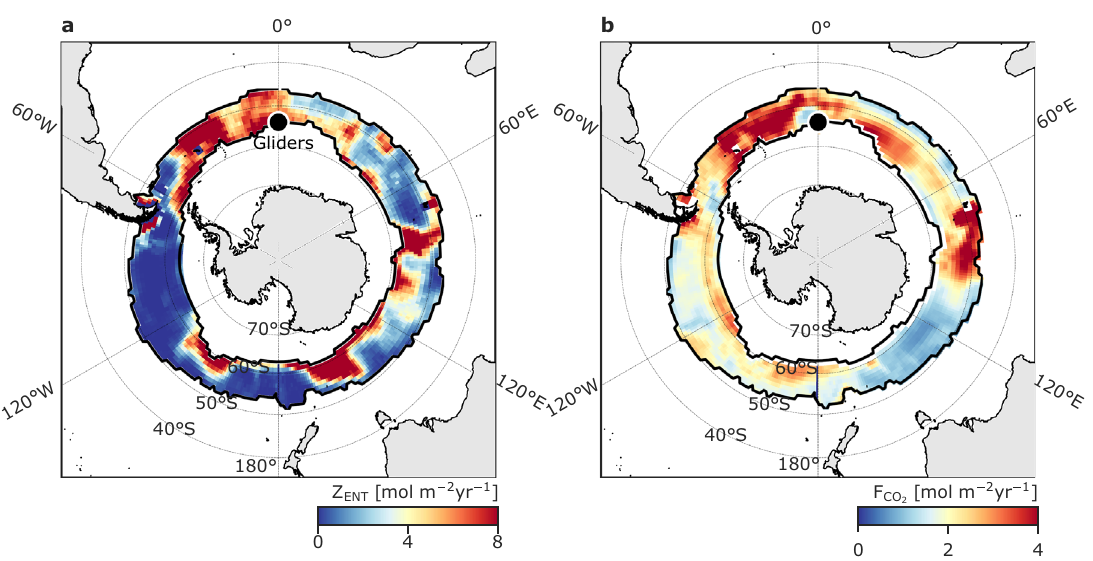
Fig. 5 Storm-driven entrainment has the same order-of-magnitude effect on the mixed-layer DIC budget as the air-sea CO 2 fl ux across the subpolar Southern Ocean. For perspective, we plot a the climatological annual mean entrainment fl ux (Z ENT , see Eq. 4 and refer to Methods) of Dissolved Inorganic Carbon (DIC) [mol m − 2 yr − 1 ] in comparison with b the climatological seasonal amplitude of the seasonal cycle in the CO 2 fl ux (F CO2 ) [mol m − 2 yr − 1 ] from CSIR-ML6 1, 41 . Both a and b are estimated over the period 2005 – 2019. Both a and b may be compared with the time-mean F CO2 in Fig.